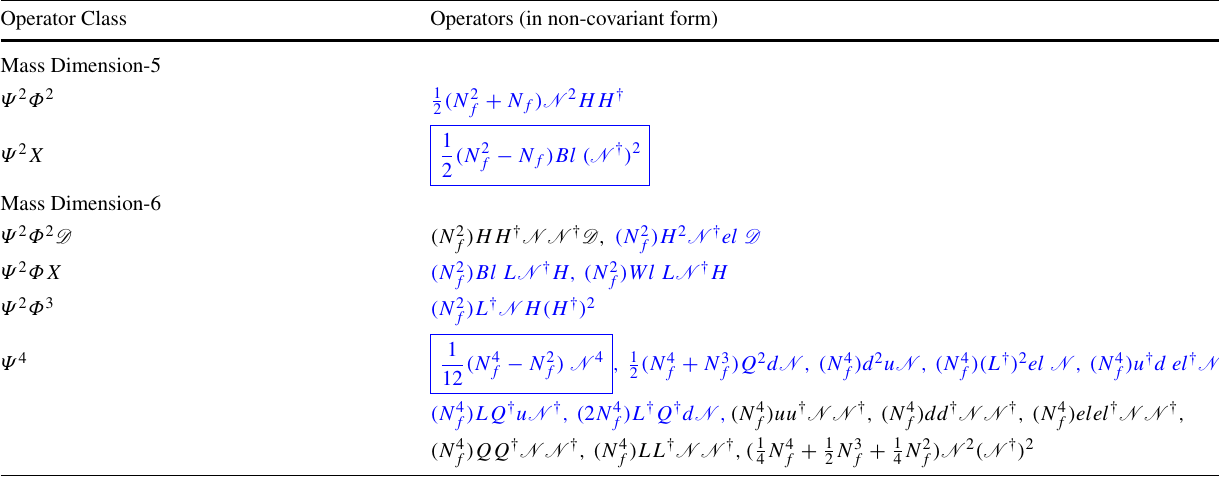
Table 37 SM + right-handed singlet fermion( N ): operators of mass dimensions-5 and -6 excluding pure SM operators Operator